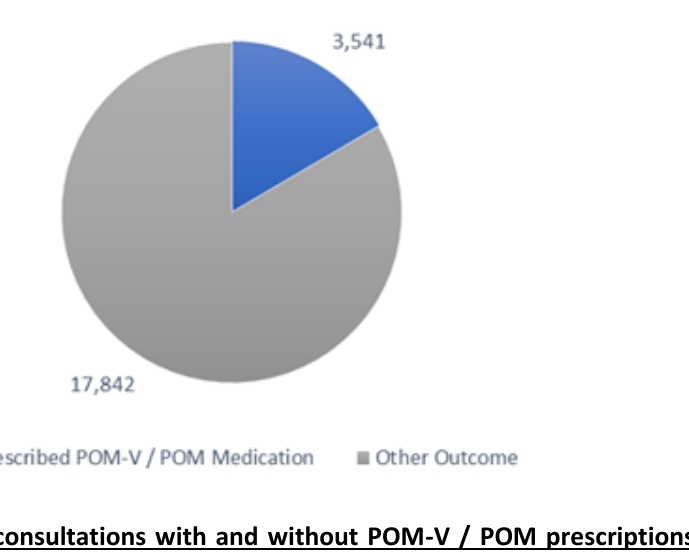
Figure 1: Total completed video consultations with and without POM-V / POM prescriptions for the audit